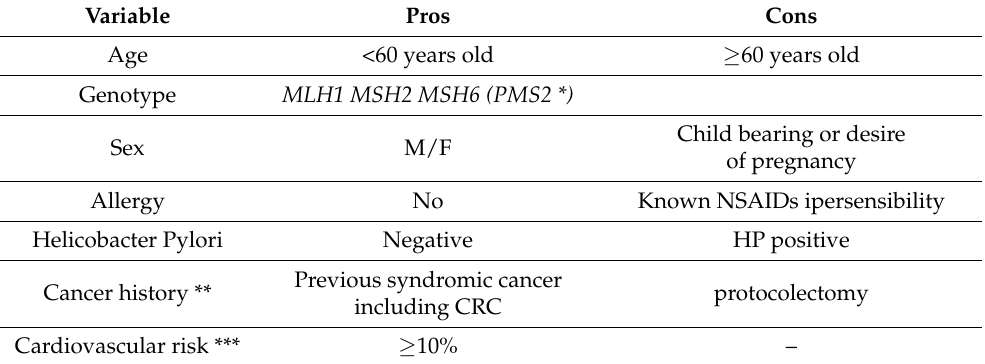
Table 2. Schema of Pros and Cons to consider for aspirin as cancer prevention agent in LS carriers. Variable Pros Cons Age <60 years old Genotype Child bearing or desire M/F of pregnancy Allergy No Known NSAIDs ipersensibility